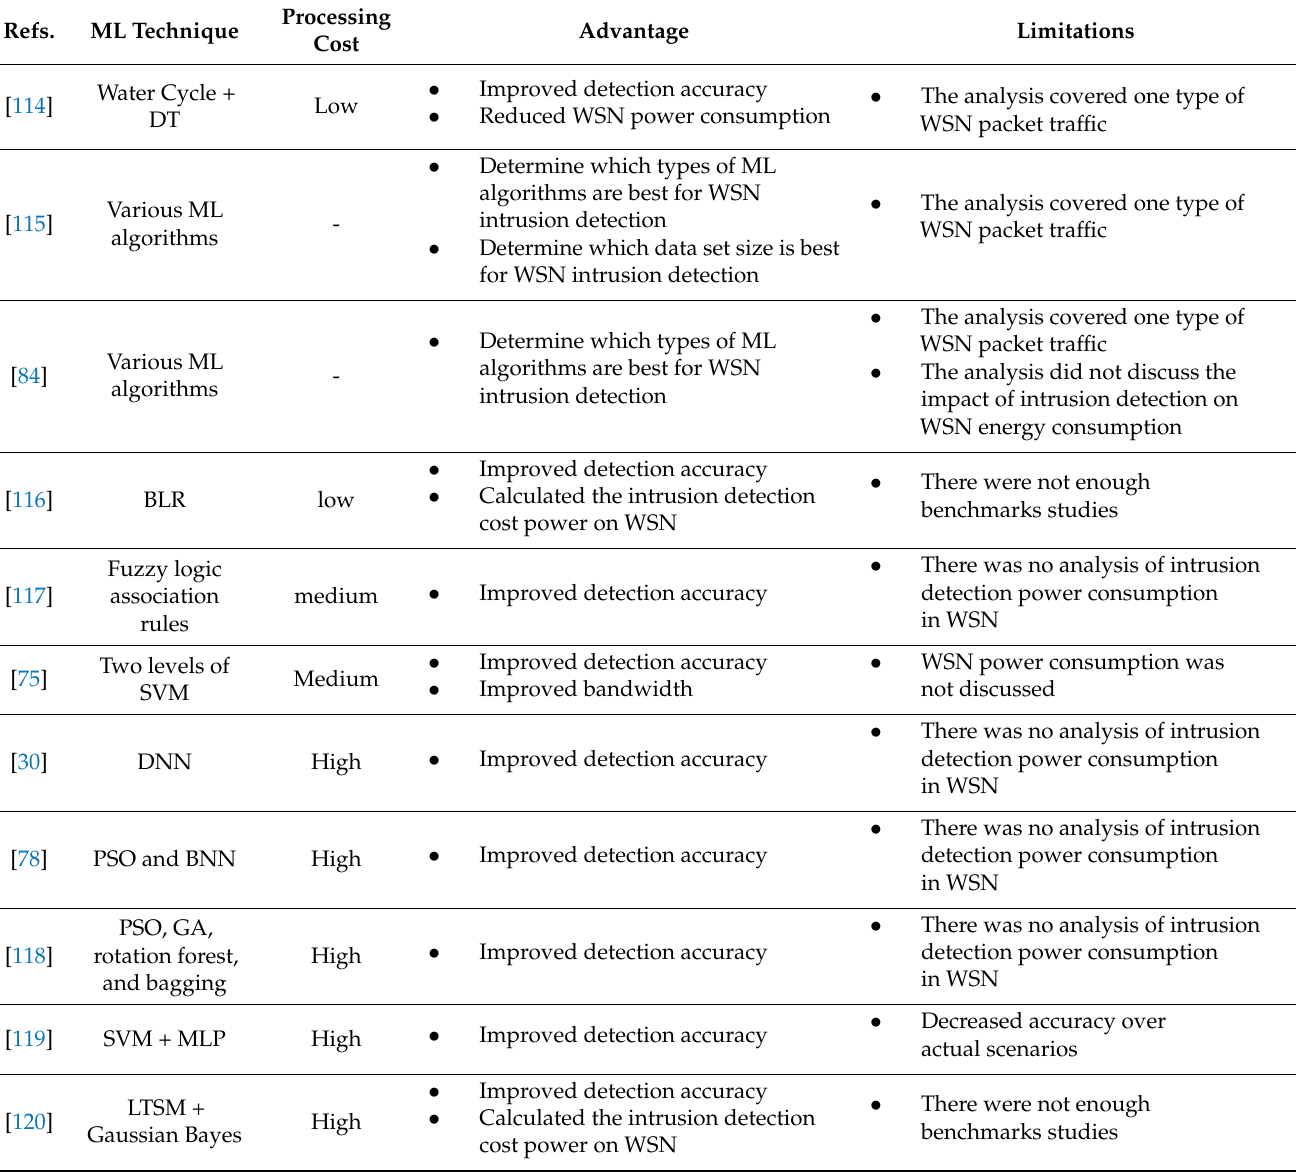
Table 4. Summary of reviewed ML algorithms in intrusion